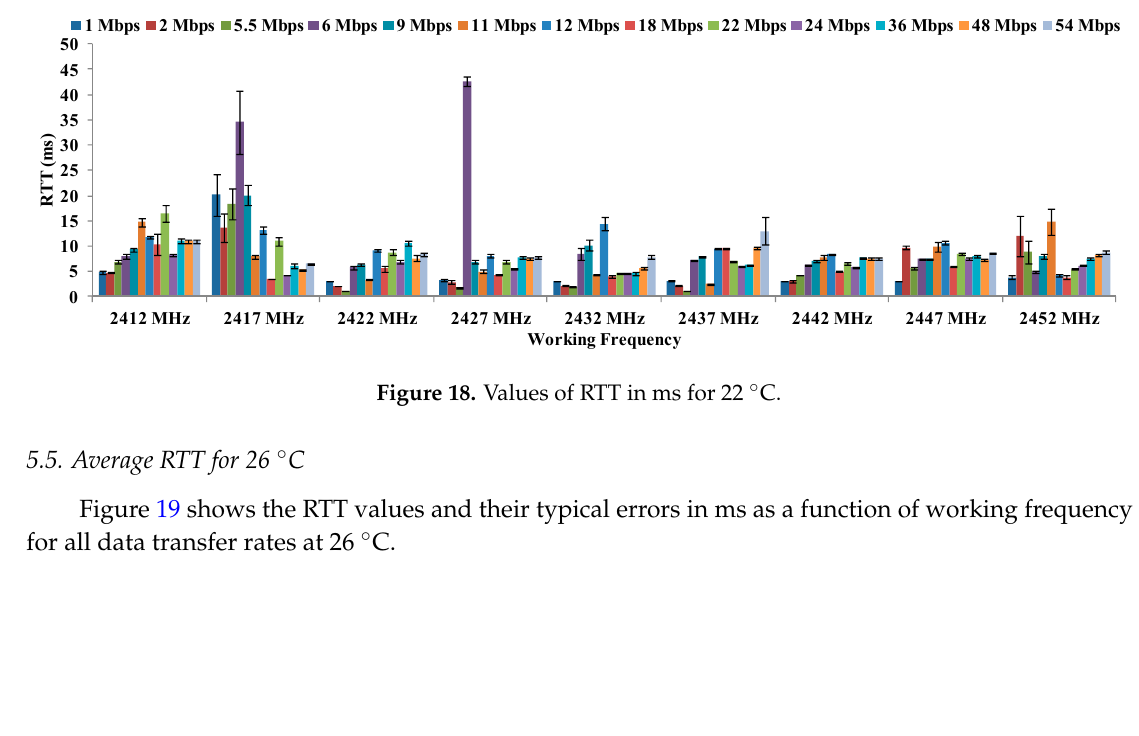
Figure 19. Values of RTT in ms for 26 °C.